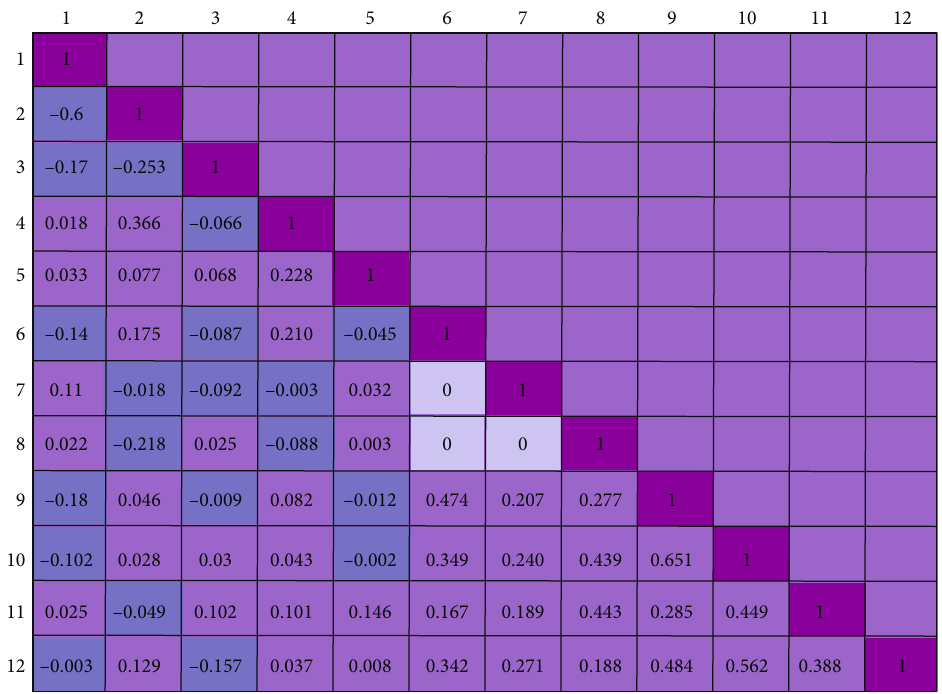
Figure 10: Correlation analysis of formal research study